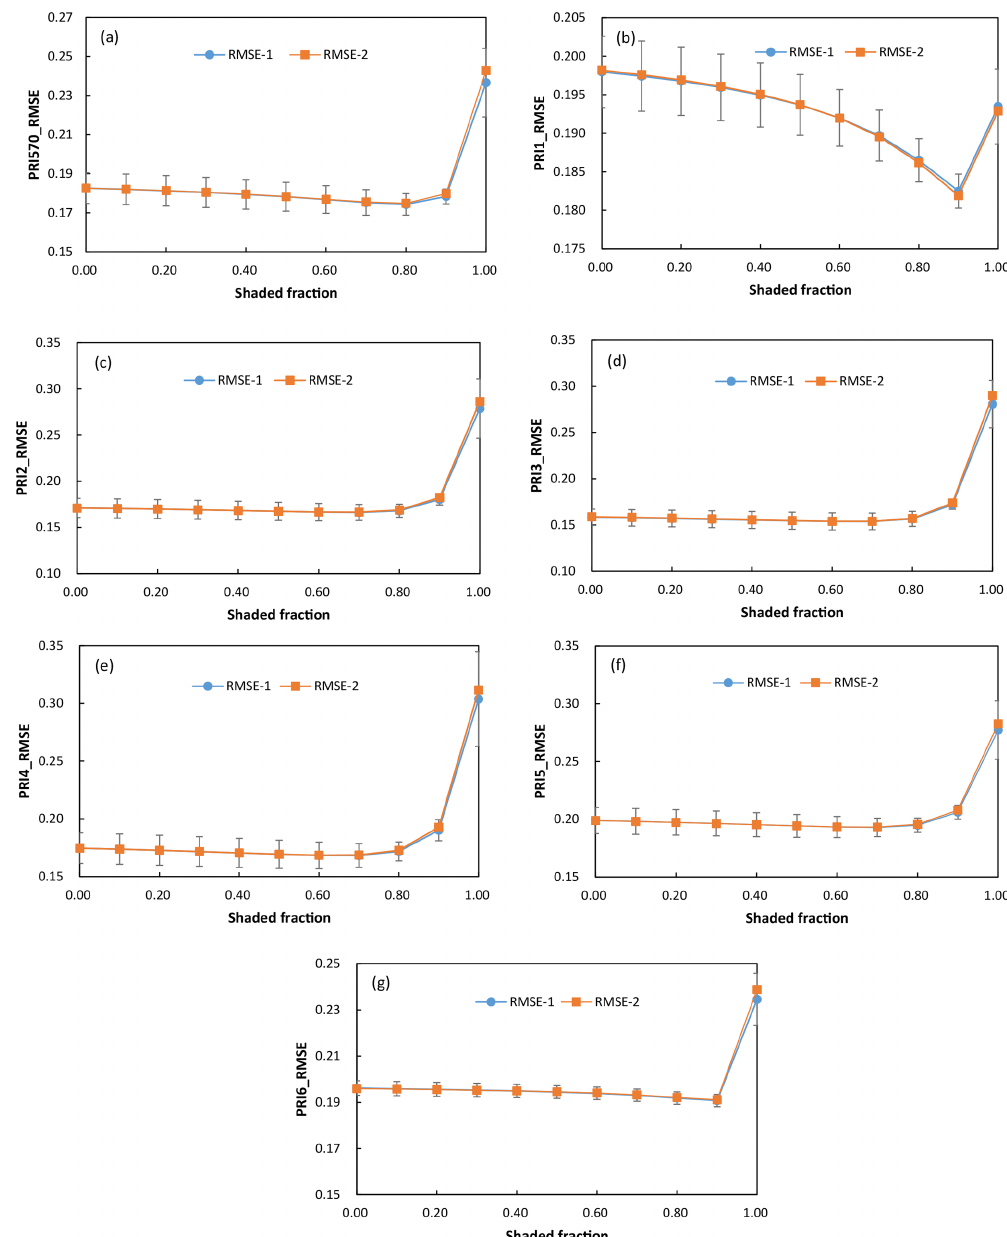
Figure 6. RMSE of RWC estimated with PRI570 ( a ), PRI1 ( b ), PRI2 ( c ), PRI3 ( d ), PRI4 ( e ), PRI5 ( f ), and PRI6 ( g ) under different shaded- leaf fractions. RMSE-1 means RMSE of RWC estimated with the linear regression model derived from the PRI of the sunlit / shaded leaves ratio of 50 / 50; RMSE-2 means RMSE of RWC estimated with the linear regression models geared towards the known shaded-leaf fractions. Given the known shaded-leaf fractions, the slope and intercept of the linear regression models were estimated with the quadratic functions.